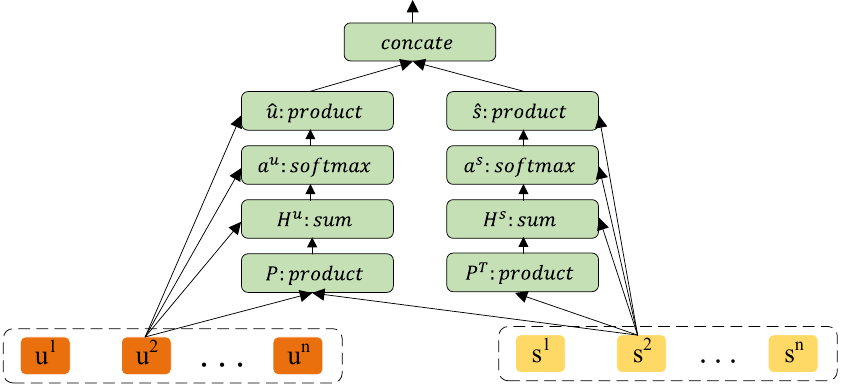
Figure 3. User-source co-attention